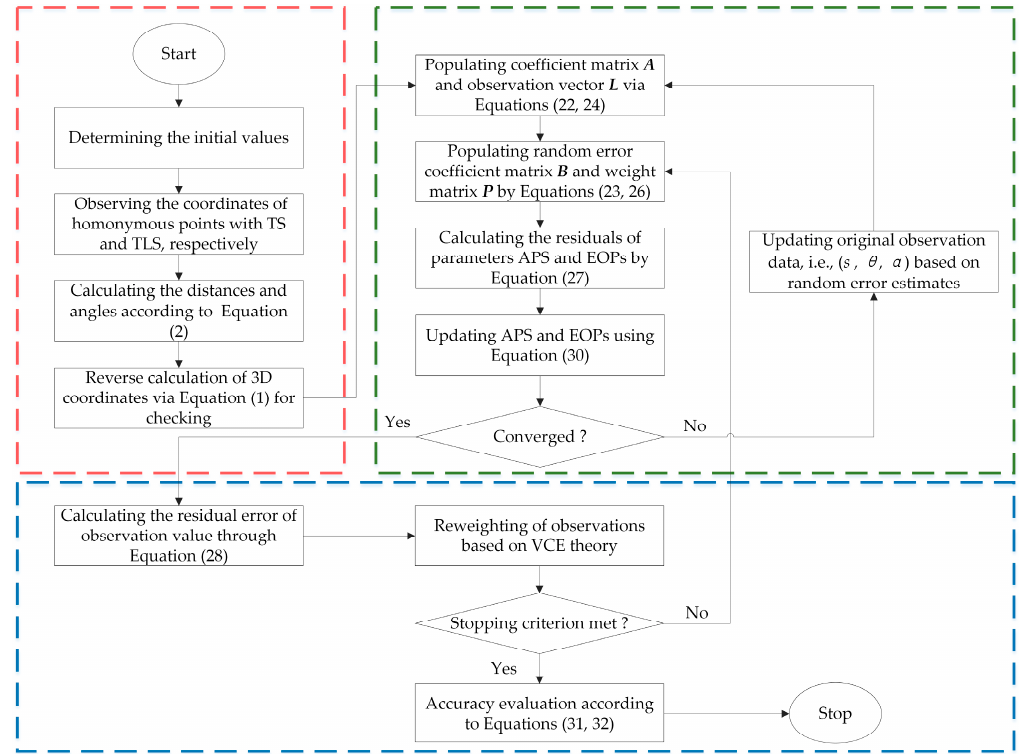
Figure 2. A flowchart of the general self-calibration method. The red part indicates the process of initialization and coordinate conversion, while the green and blue parts indicate the a priori processing and a posteriori estimation procedure of the proposed general self-calibration method, respectively.